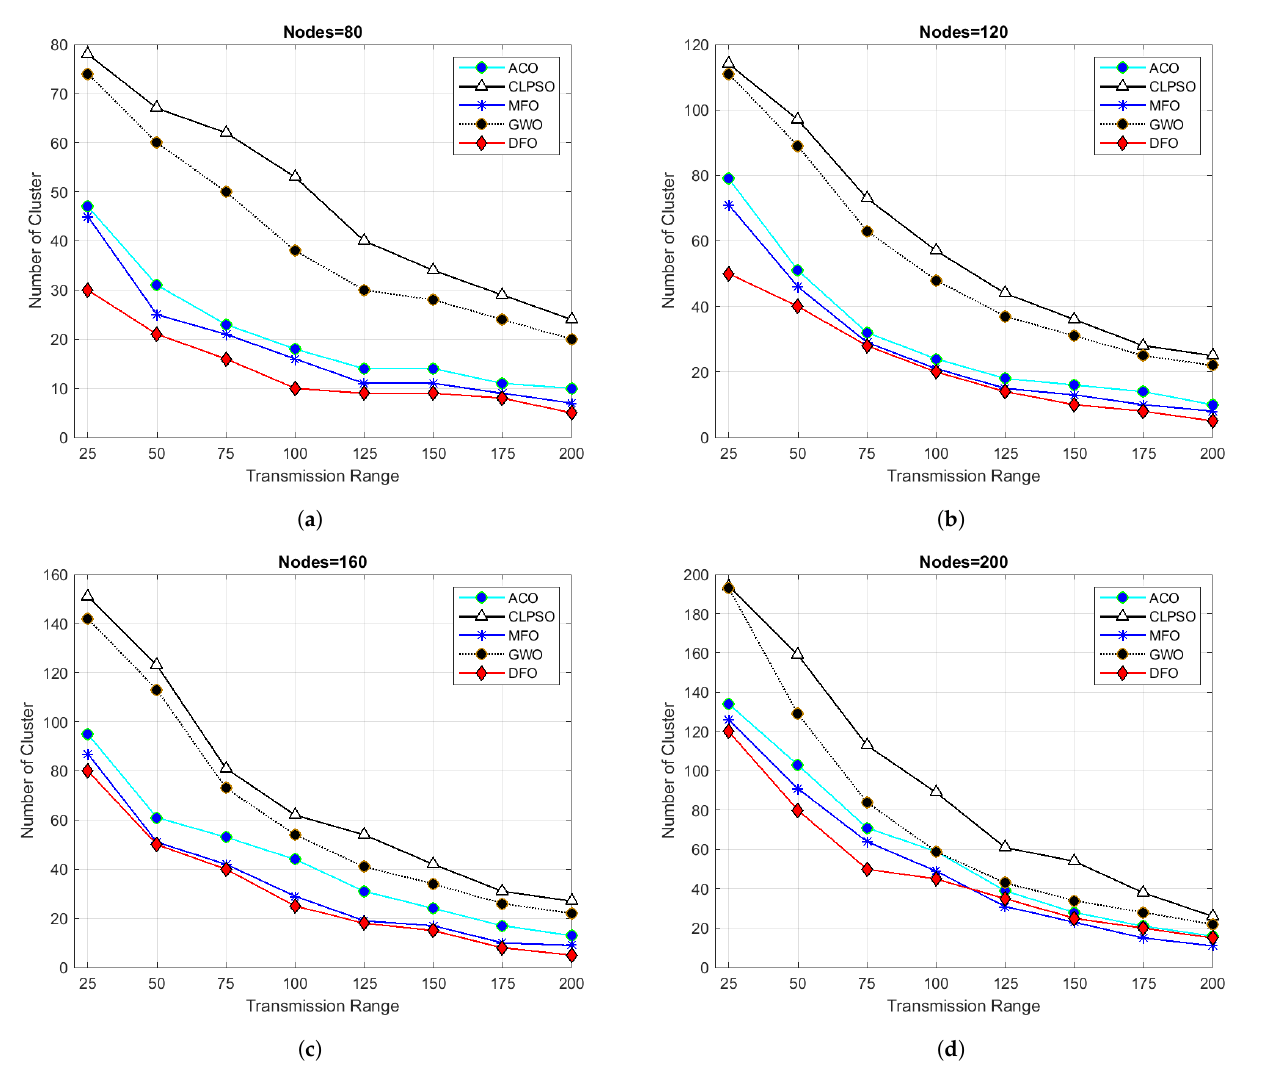
Figure 11. Grid size 2000 m × 2000 m and transmission range from 25 to